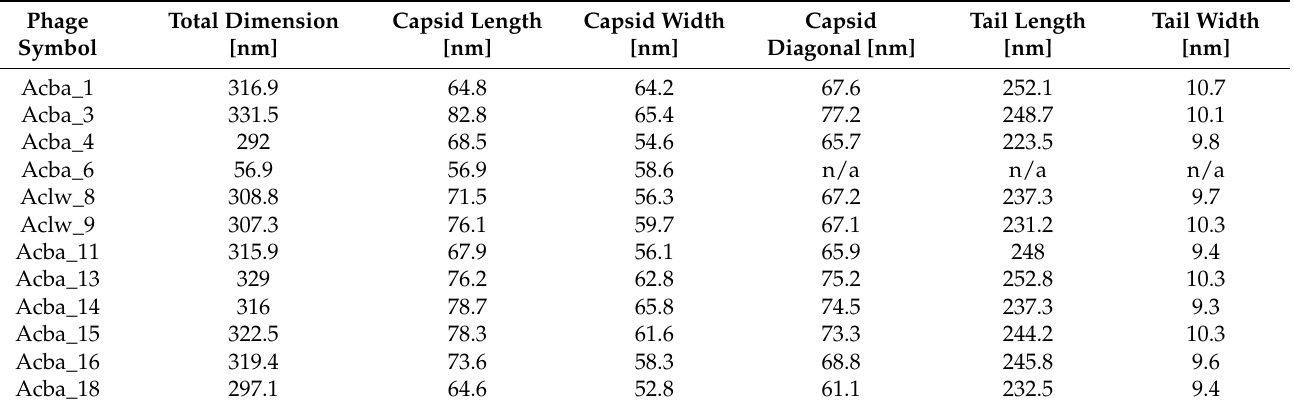
Table 3. The dimensions of the bacteriophages were determined based on the measurements of ten virions for each of 12 phages.